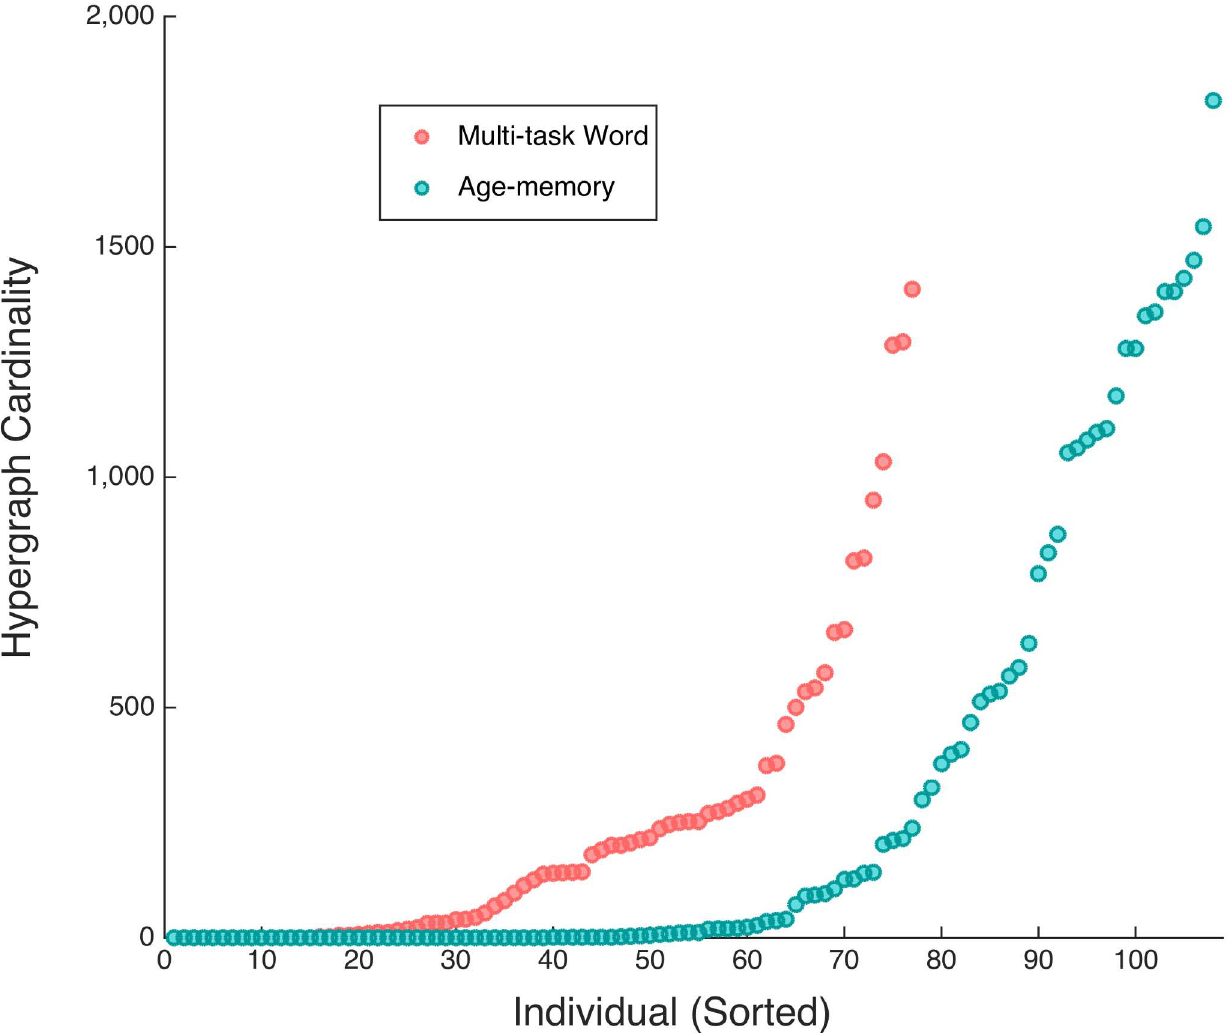
Fig 8. Sorted hypergraph cardinality. Increasing hyperedge cardinality for individualmulti-task word-only and age-memoryhypergraphs. The variability for both studies is similar to the variability in multi-task overall hypergraph cardinality, depicted in Panel (A) of Fig 5. The range of hypergraph cardinalities for subjects in the word-onlydata is smaller than either the overall multi-task study or age-memory